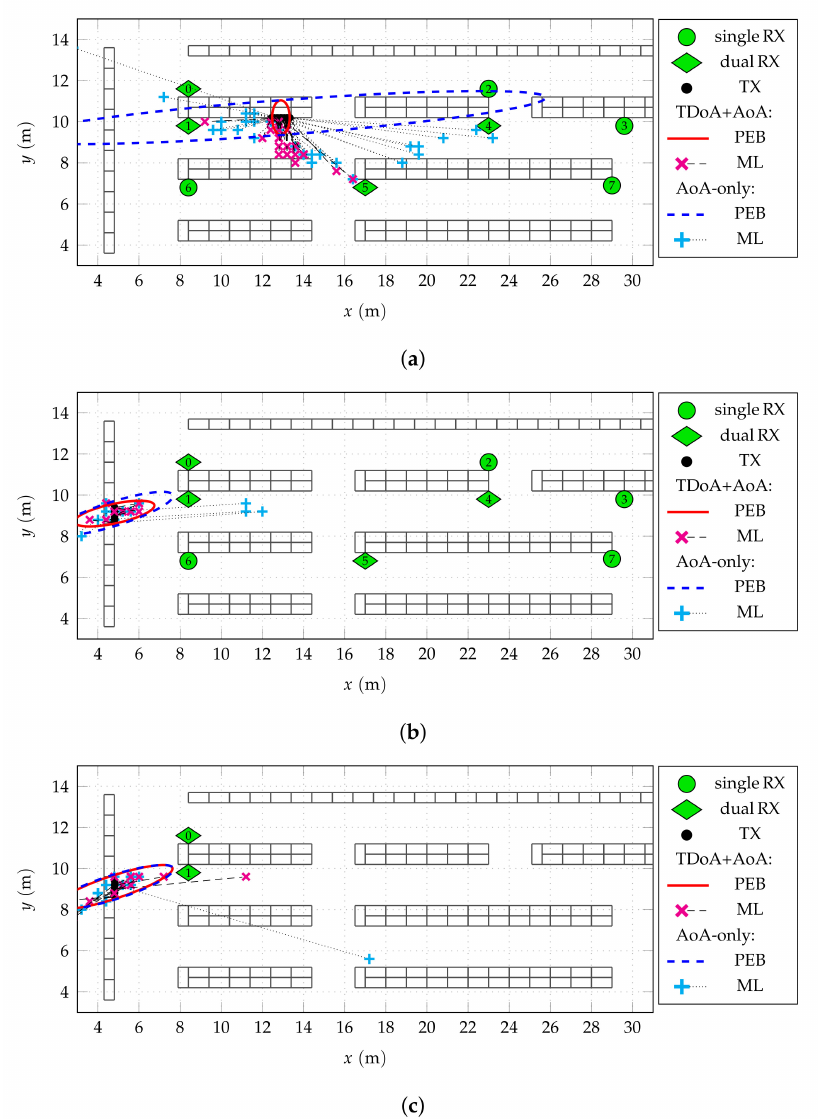
Figure 6. Position estimates for selected shelves and different receiving anchor configurations. Both TDoA+AoA as well as AoA-only estimates are shown. The 99% position error bound (PEB) ellipses are indicated for both methods. The spatial resolution is 40cm. ( a ) Shelf with 29 nodes in aisle 2 and all anchors active. ( b ) Shelf with 14 nodes in aisle 0 and all anchors active. ( c ) The same shelf with with only anchors l = 0,1